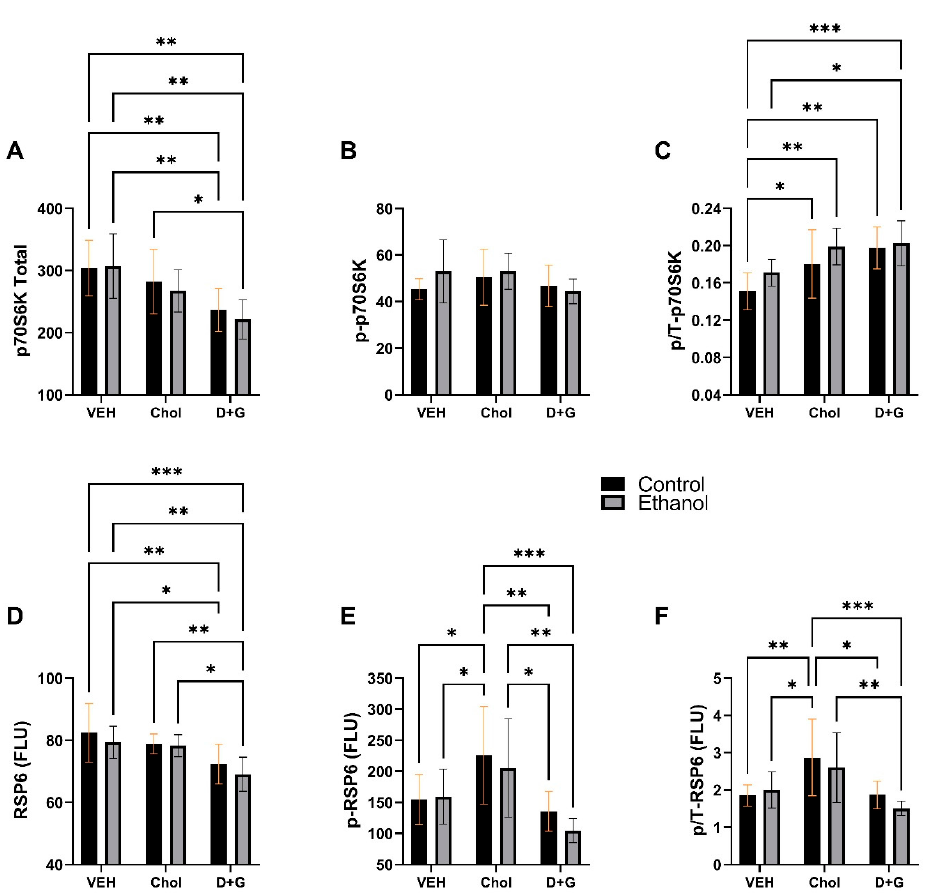
Figure 7. Ethanol and treatment ( Chol and D+G) effects on key downstream signaling molecules in the Insulin/IGF-1-Akt-mTOR pathway. ( A ) p70S6K, ( B ) pT412 -p70S6K, ( C ) p/T-p70S6K, ( D ) RPS6, ( E ) pS235/236 -RPS6, ( F ) p/T-RPS6. Graphs depict the mean ± SD of results (N = 6